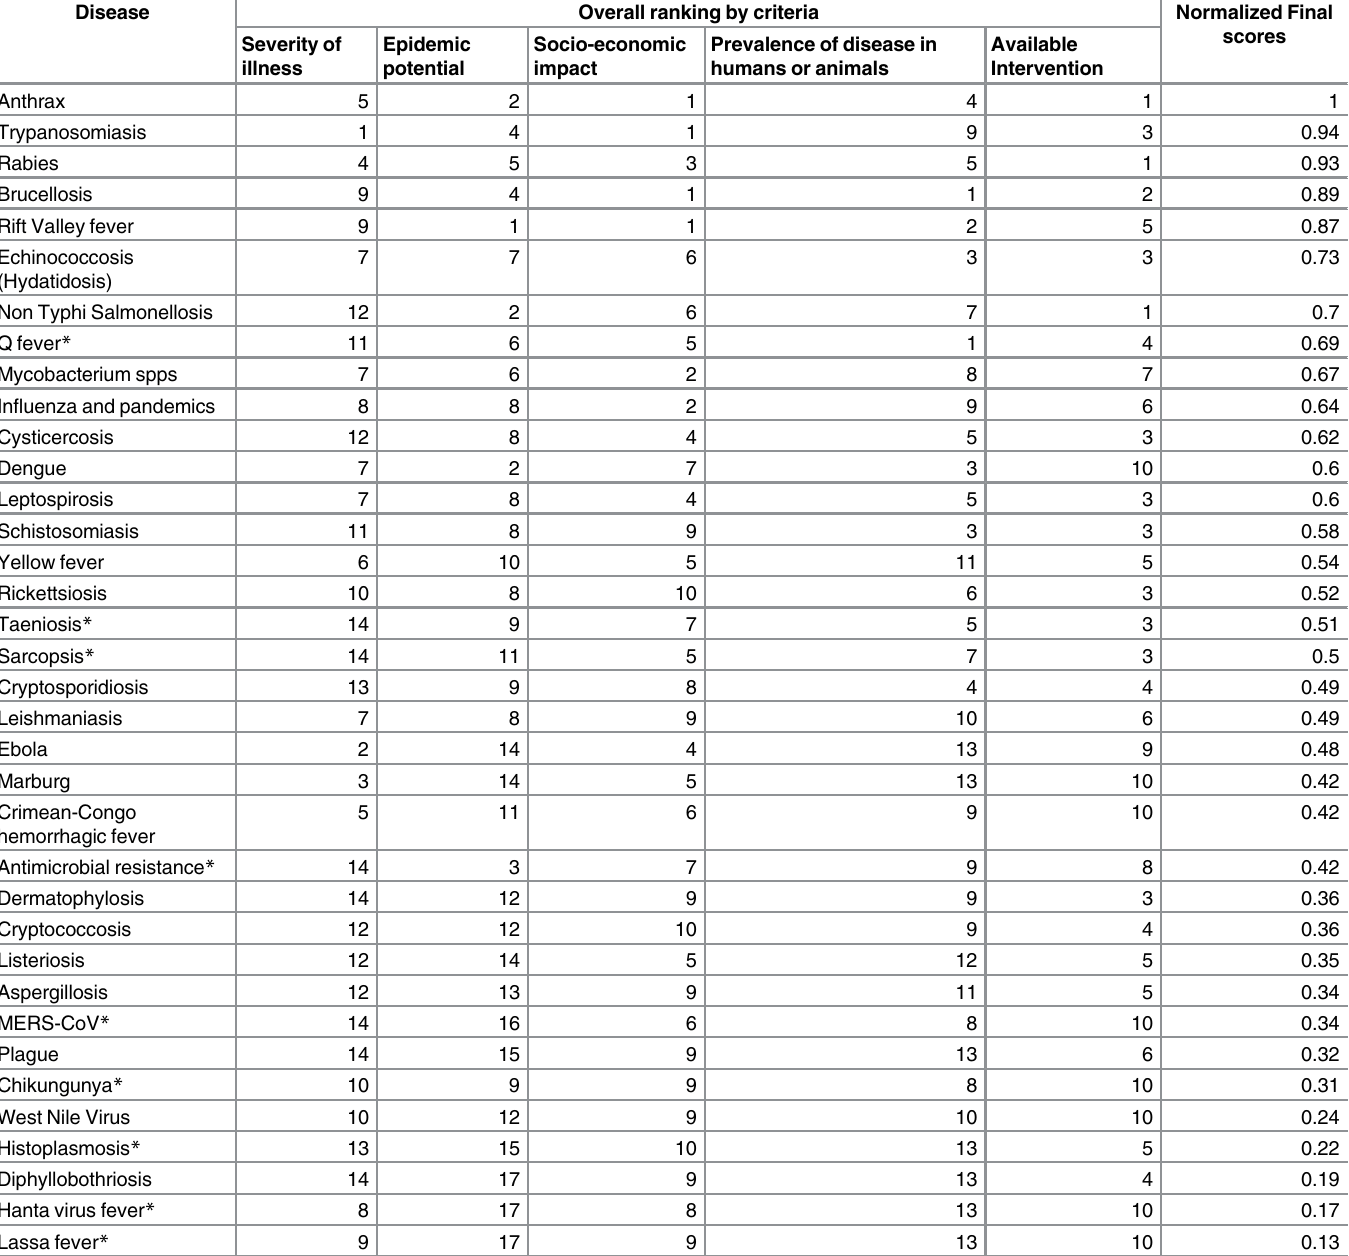
Table 3. Ranked Priority disease list for Kenya with ranking by criteria and normalized final scores, 2015.